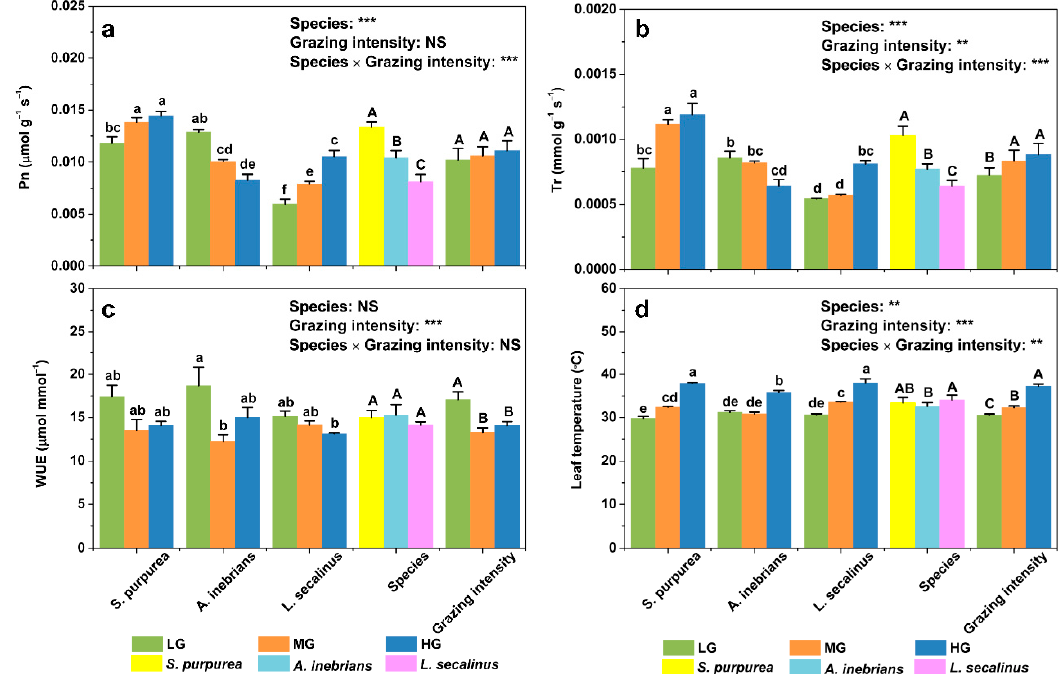
Figure 3. Mean values of photosynthesis parameters including the net photosynthetic rate (Pn) ( a ), transpiration rate (Tr) ( b ), water use efficiency (WUE) ( c ), and leaf temperature (T l ) ( d ) of the leaves of S. purpurea , A. inebrians and L. secalinus in response to grazing intensity (LG, light grazing; MG, medium grazing; HG, heavy grazing). Note: S. purpurea , Stipa purpurea ; A. inebrians , Achnatherum inebrians ; L. secalinus , Leymus secalinus . The data are presented as mean ± standard error (SE) of three independent experiments. ** p ≤ 0.01; *** p ≤ 0.001; NS, no significance. Different lowercase letters mean significant difference ( p ≤ 0.05) between same species under different grazing intensities. Different uppercase letters mean significant difference ( p ≤ 0.05) between different species or different grazing